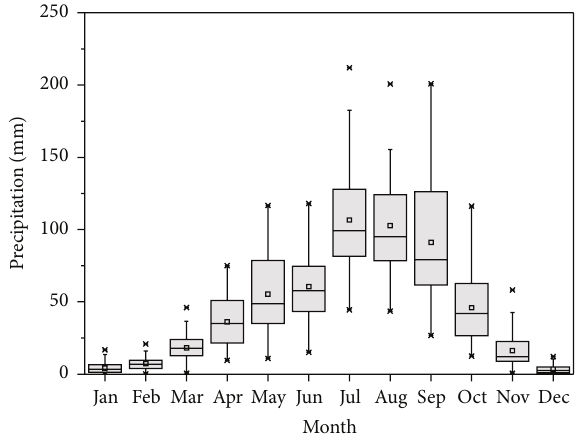
Figure 3: Definition of dry spell length during rainy season (RS). 𝐿 and 𝐿 are the length of RS and non-RS period, RS non-RS